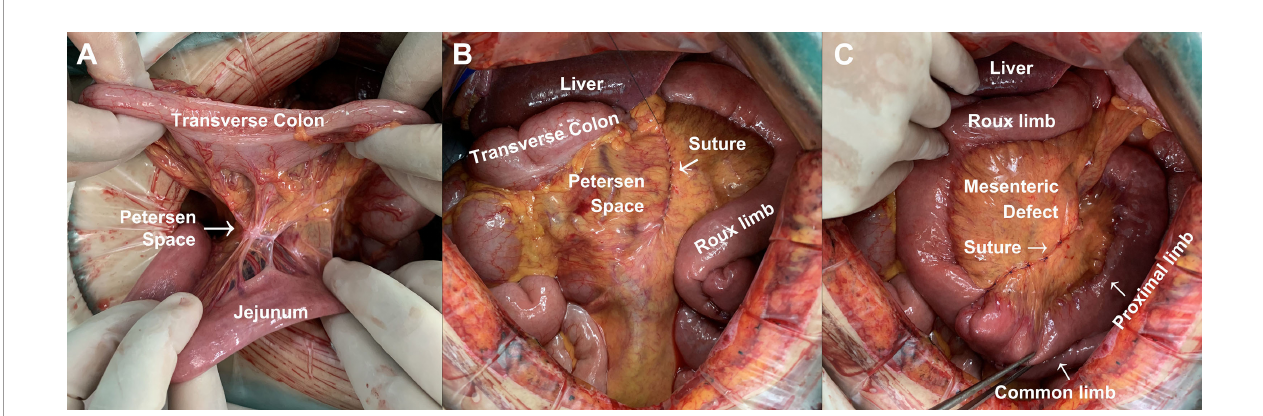
FIGURE 2 | Method for the prevention of Petersen ’ s hernia during gastrectomy. (A) Natural closure of Petersen space. (B) Continuous suturing for the closure of Petersen space during gastrectomy. (C) Continuous suturing for the closure of mesenteric defect during